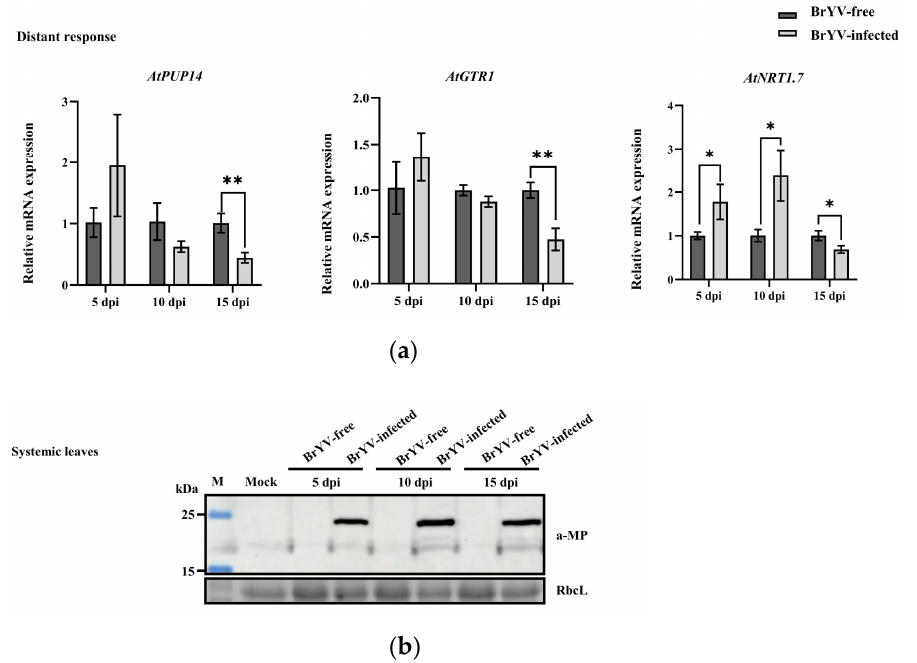
Figure 4. Relative mRNA levels of the AtPUP14 , AtGTR1 , and AtNRT1.7 genes in response to BrYV infection. ( a ) Relative mRNA levels of the AtPUP14 , AtGTR1 , and AtNRT1.7 genes in response to BrYV infection at 5, 10, and 15 dpi in systemic leaves. The non-viruliferous aphids were used as a negative control, and AtActin2 was used as an internal control . Student’s t-test was employed to determine statistically significant differences (* p < 0.05; ** p < 0.01); ( b ) Detection of BrYV-MP accumulation in A. thaliana systemic leaves inoculated with viruliferous aphids or non-viruliferous aphids.